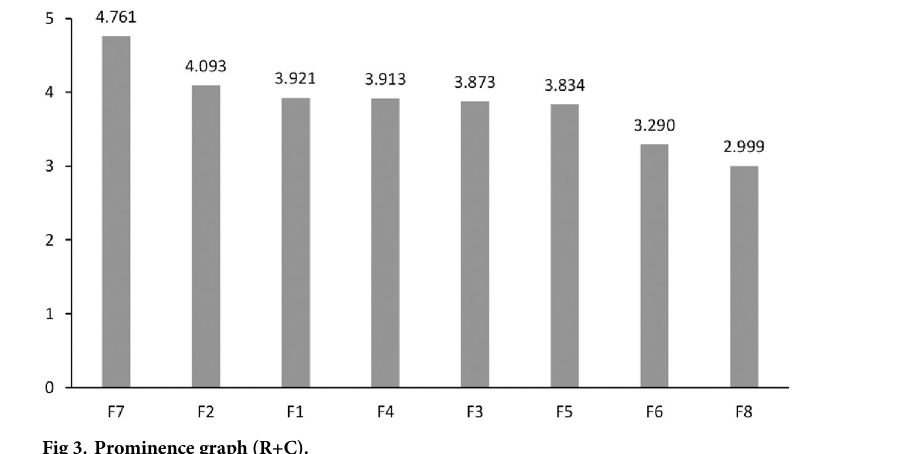
Fig 3. Prominence graph (R+C).